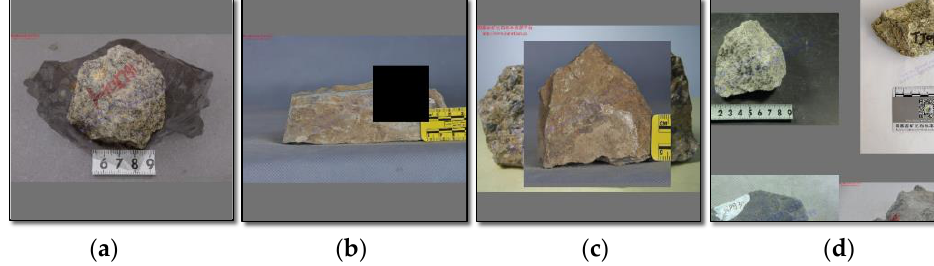
Figure 10. Four kinds of data augmentation results. ( a ) mix-up, ( b ) cut-out, ( c ) cut-mix, and ( d ) stitching methods.